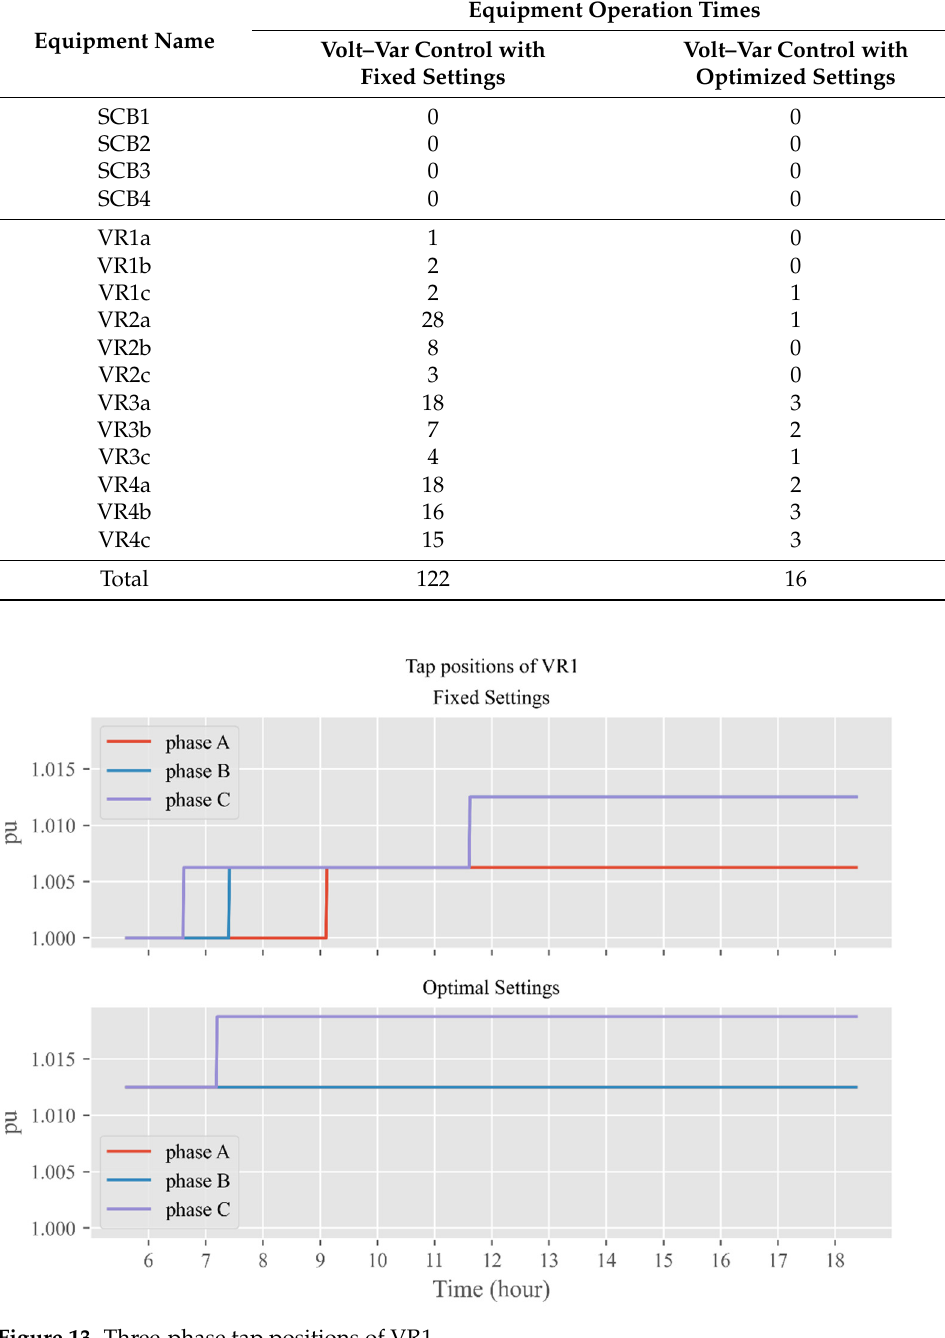
Figure 13. Three-phase tap positions of VR1.